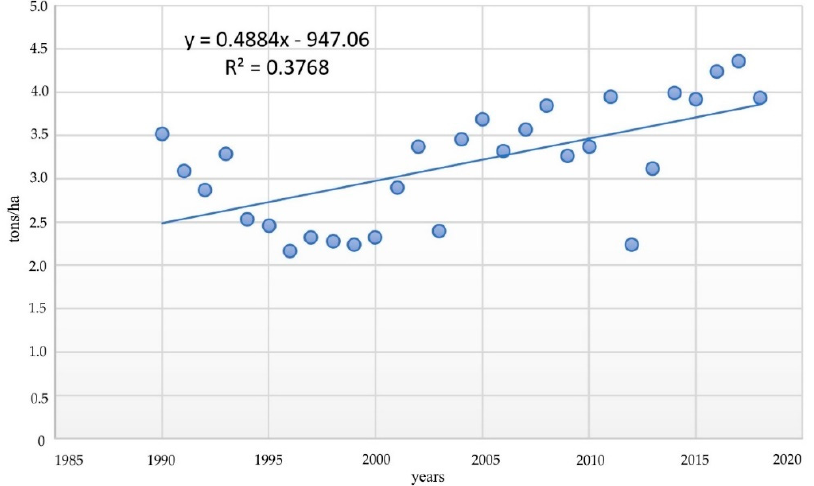
Figure 5. Winter wheat yields in 1990–2020, tons/ha. Source: authors’ development based on [123,124].